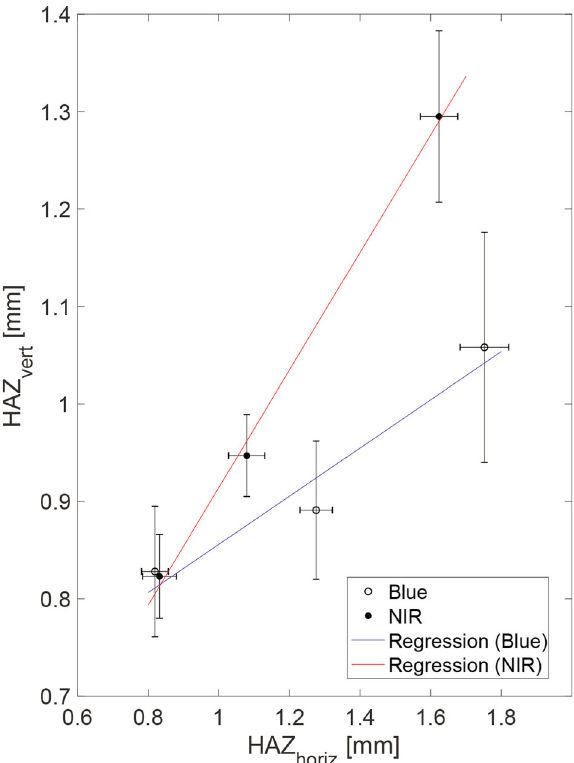
Fig. 8 Comparing horizontal and vertical heat-affected zones (HAZ) from laser cooking. Maximum depth is plotted against maximum width of the HAZ. Each data point presents a standard error that was tabulated from fi ve repeated experiments ( n = 5). The values from each experiment were measured three times and averaged to minimize the error associated with the measuring technique. Information regarding the method used to calculate HAZ can be visualized in Supplementary Fig. S17. Error bars represent standard error of the